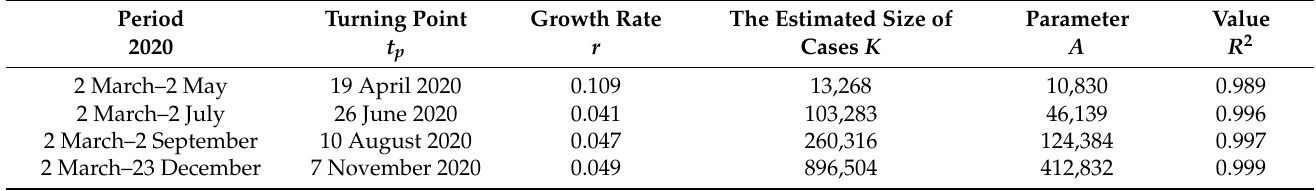
Table 5. The estimation results of parameters in the logistic growth model for various periods from daily cases data of COVID-19 infected in Indonesia based on data compiled by WHO [18].